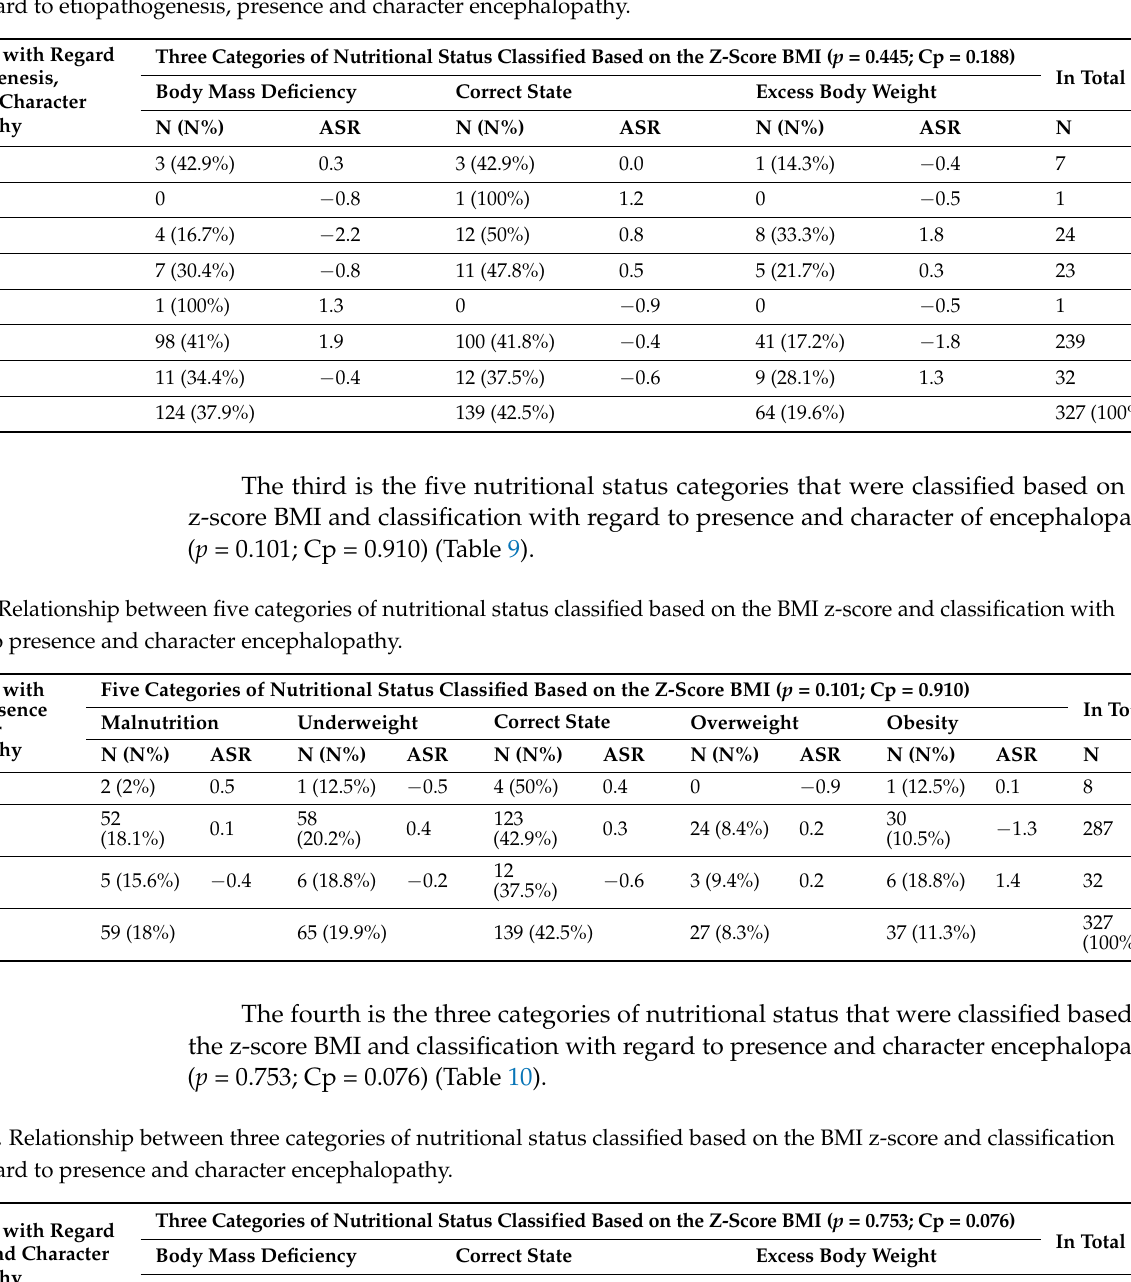
Table 8. Relationship between three categories of nutritional status classified based on the BMI z-score and classification with regard to etiopathogenesis, presence and character encephalopathy.